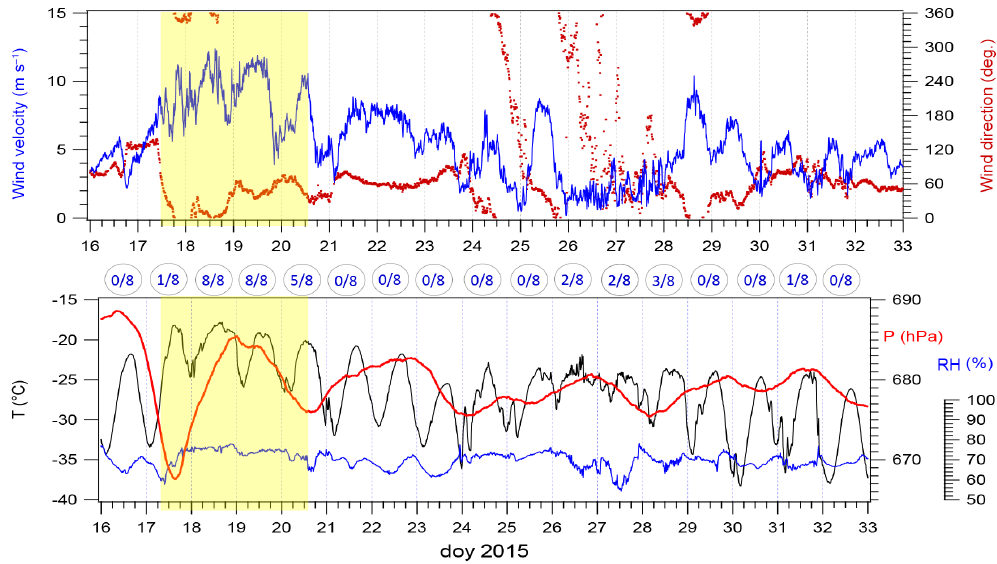
Figure 3. Time series of the measured meteorological parameters in 2015 (60s temporal resolution). The period of LPS15 is shaded in yellow. The cloud amount in oktas is denoted on the top of the second figure based on casual visual inspection.